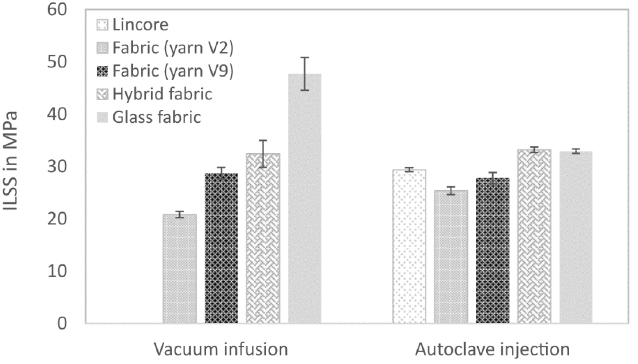
Figure 13. Interlaminar shear strength (ILSS) of composites produced by vacuum infusion and autoclave injection. Results are shown as mean values with standard deviation as error bars.